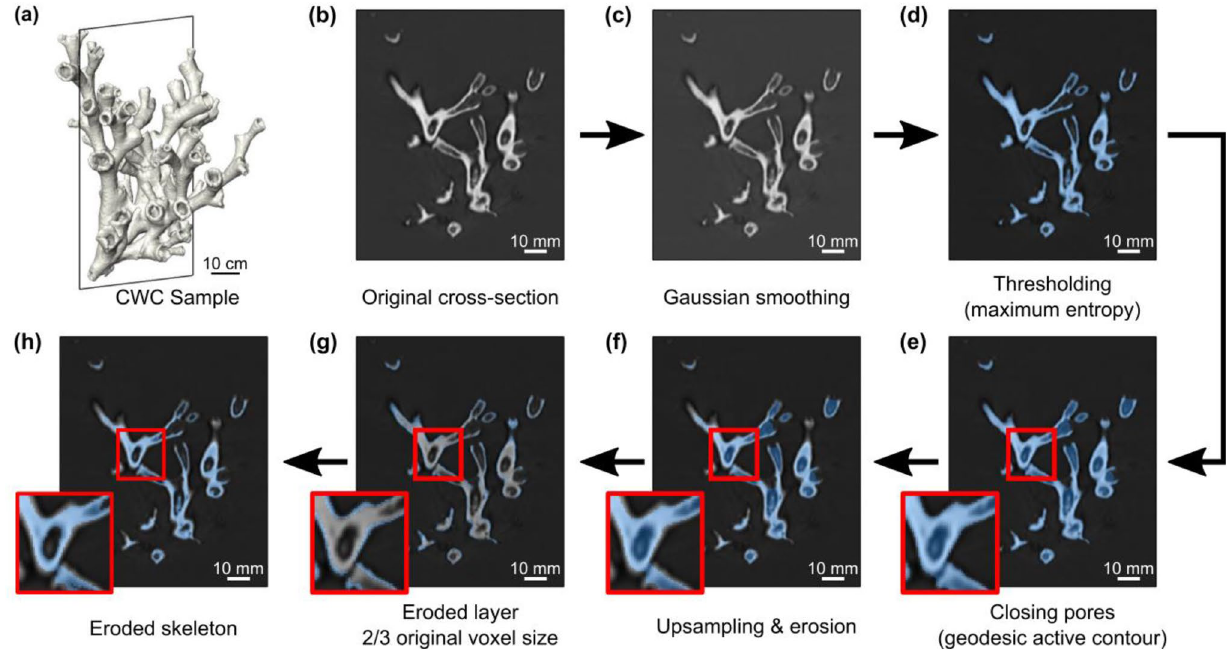
Figure 5. Incorporating dissolution on a representative coral specimen: ( a ) 3D render of the exemplary cold-water coral (CWC) specimen. ( b ) Original cross-section through the XZ plane; ( c ) Gaussian filter was 0.3 ); ( d ) Coral skeleton was segmented using Maximum Entropy algorithm threshold; ( e ) A 3D applied ( σ = morphological geodesic active contour algorithm was implemented to detect the outer surface and fill the pores and cavities in the skeleton. ( f ) The contour image was up-sampled and eroded in steps of 1/3 of the original voxel size. ( g ) 0.23 mm eroded layer (blue) superimposed to the original CT cross-section (grey) and 0.23 mm eroded layer (blue). ( h ) Final image composite of the eroded coral skeleton (blue) and the original CT cross- section (grey). See Video S3 for a visualisation of the image processing steps as well as Figure S6 for the finite element